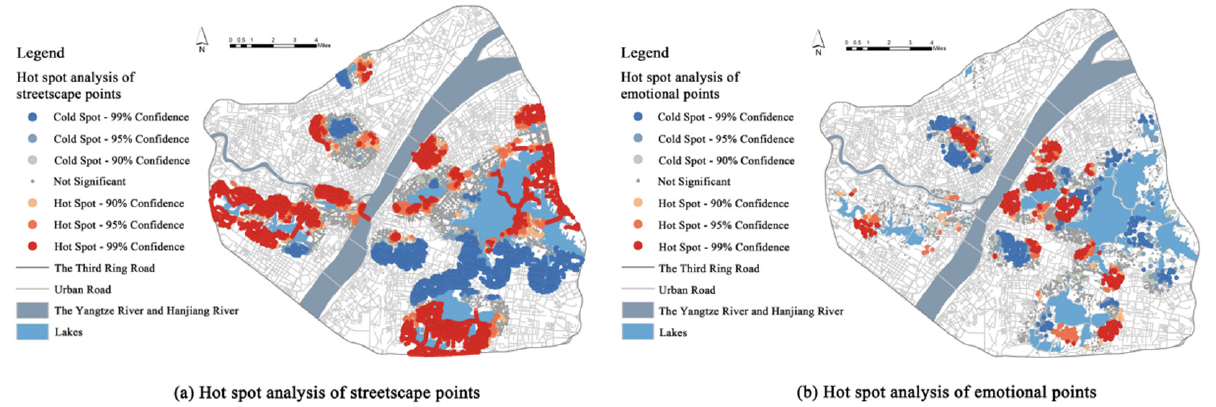
Figure 9. Hot spot analysis results of streetscape points ( a ) and emotional points ( b ).